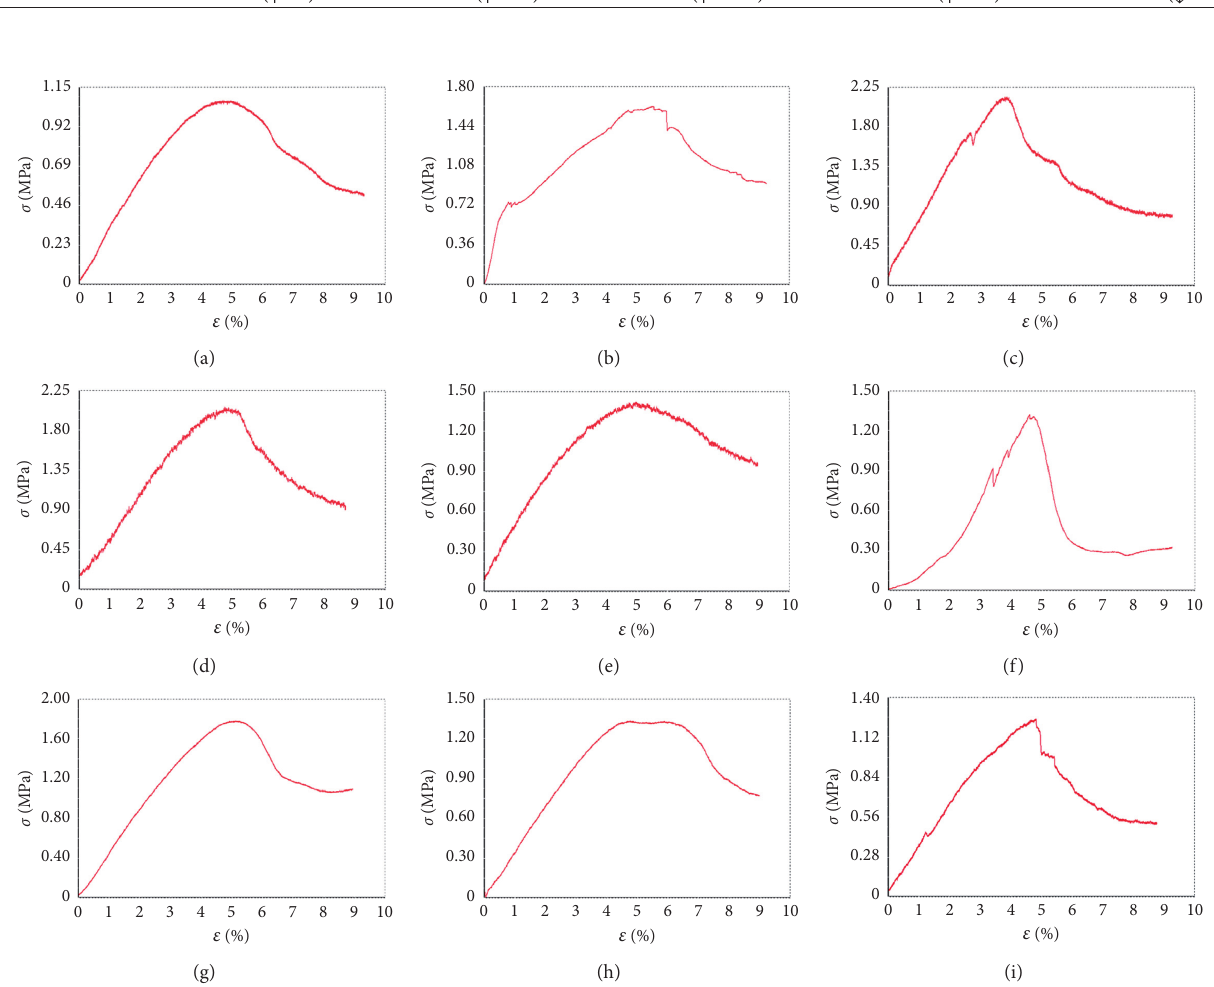
Figure 4: Unconfined compression test stress-strain curves of reinforced loess. (a) Test-1. (b) Test-2. (c) Test-3. (d) Test-4. (e) Test-5. (f) Test-6. (g) Test-7. (h) Test-8. (i)